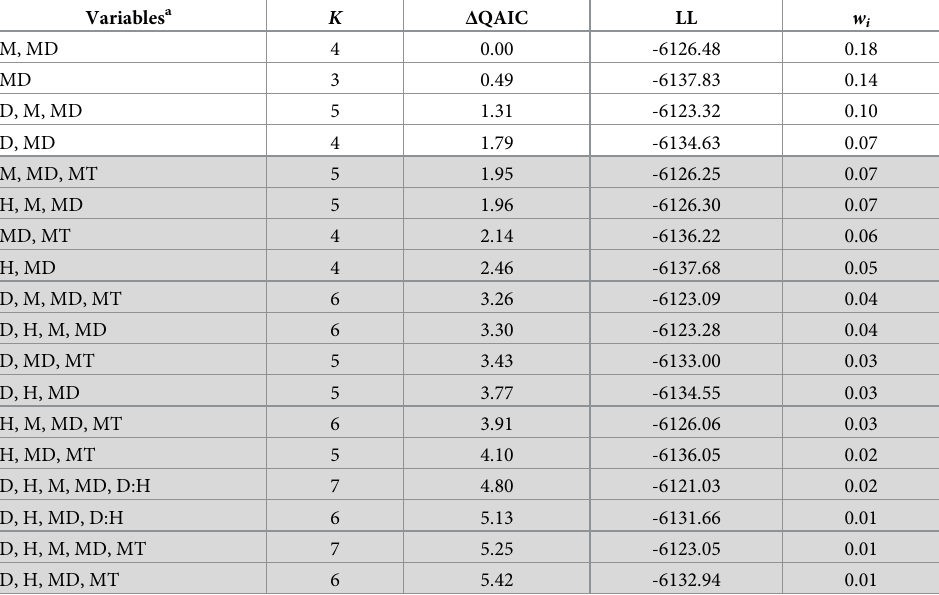
Table 7. Variables, number of parameters ( K ), delta Quasi-AIC ( Δ QAIC), log-likelihood (LL), and QAIC weights ( w i ) for birds-only top model set. Shaded rows represent models with uninformative